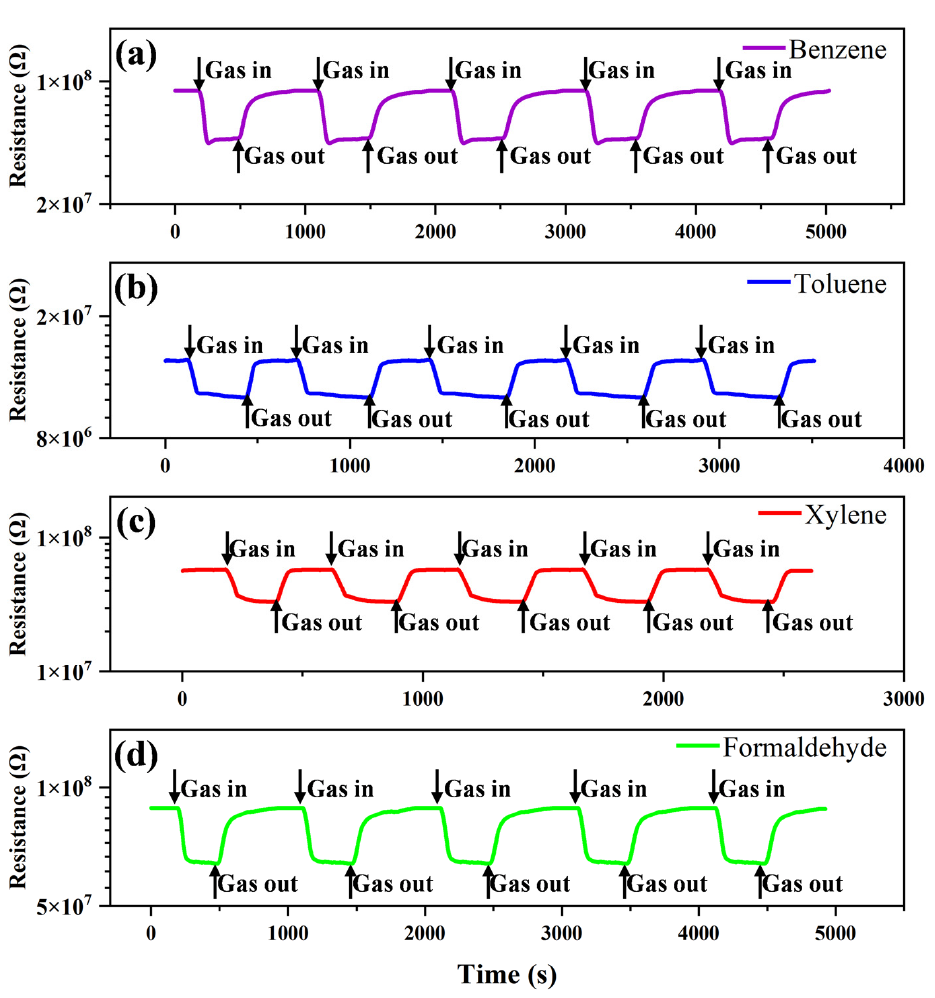
Figure 6. R – T curves of pristine WO 3 (Sensor 1) at 250 °C for 100 ppm of ( a ) benzene, ( b ) toluene, ( c ) xylene, and ( d ) formaldehyde.